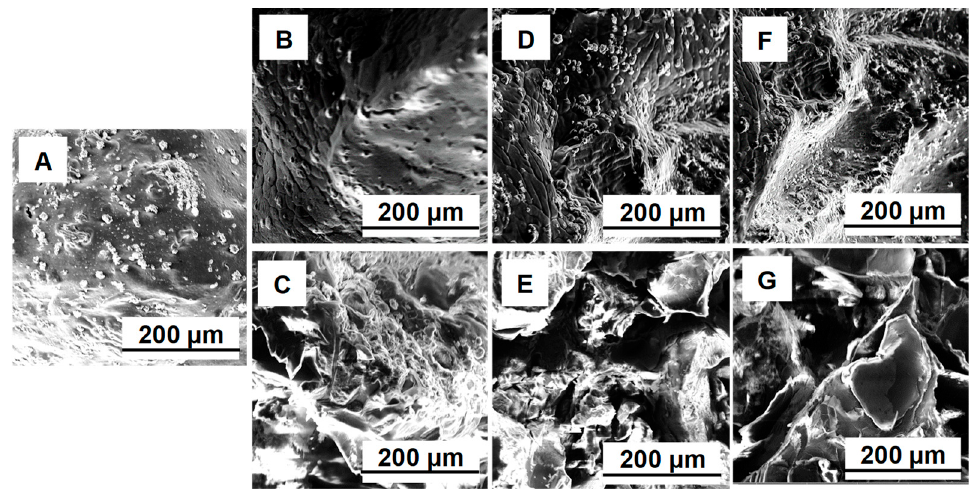
Figure 7. SEM images for the prepared adsorbent before RB adsorption ( A ), after 1st, 2nd and 3rd cycle of RB adsorption ( B , D , F ) and after 1st, 2nd and 3rd cycle of RB desorption ( C , E , G ) (Device: TESCAN MIRA (TESCAN Orsay Holding, Brno, Czech Republic); Detection mode: Normal secondary electron in high vacuum; Detector: large field detector; Accelerating voltage: 20 keV; Beam current: 300 pA; Magnification: 320 × ; Field of view: 873 µ m; Working distance: 5 mm; Scan speed: 6).